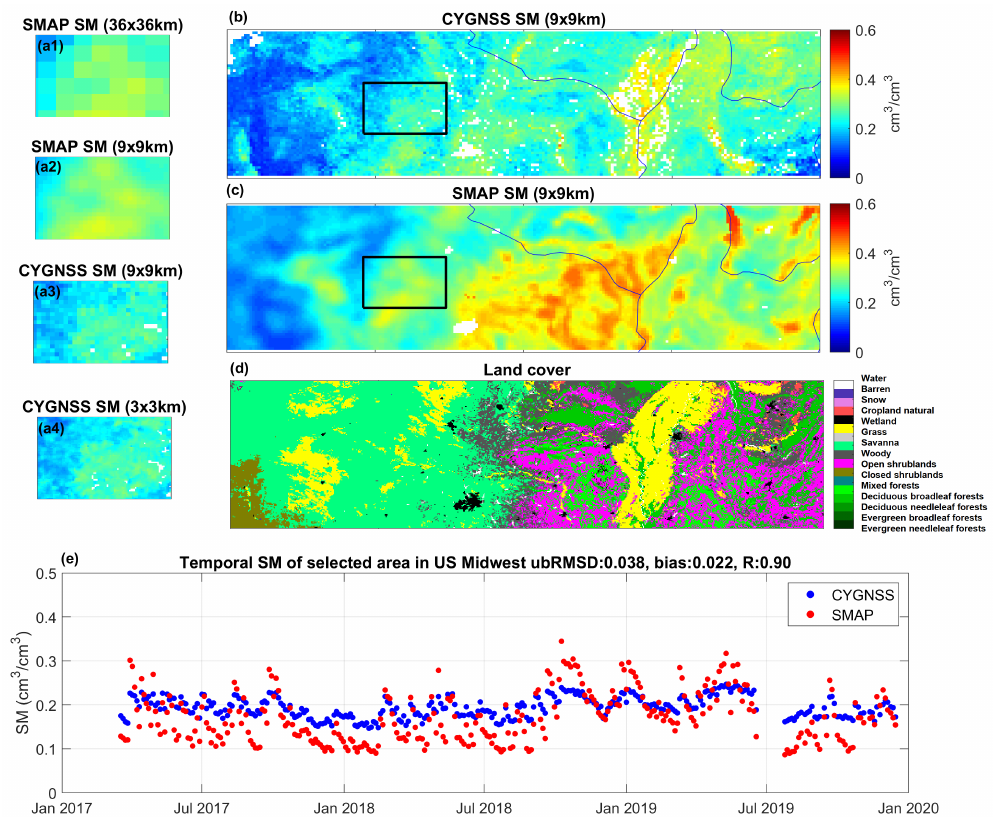
Figure 10. Averaged SM predictions for Midwest US during Jan 2018. ( a ) Detailed images of selected area for SMAP 9-km and 36-km and CYGNSS 3-km and 9-km, ( b ) CYGNSS 9-km, ( c ) SMAP 9-km, ( d ) land cover map, and ( e ) a time-series example from selected area.